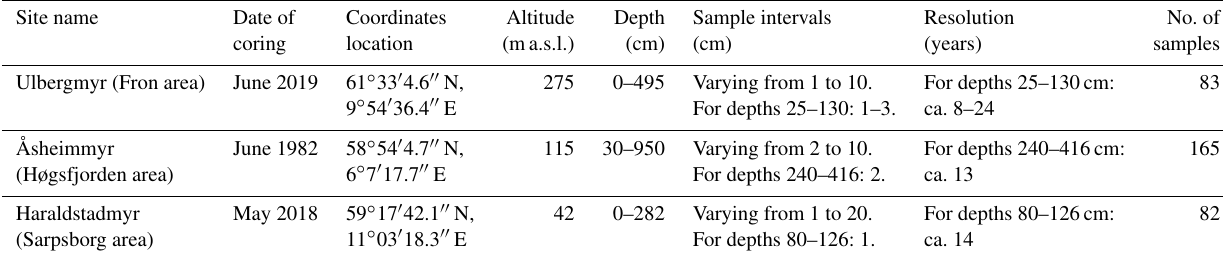
Table 3. Information about the three peat sequences collected for pollen